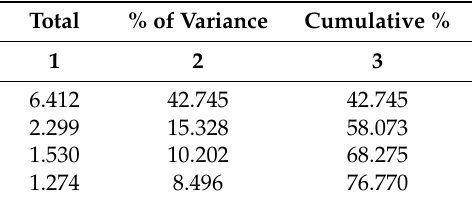
Table 1. Rotation Sums of Squared Loadings.